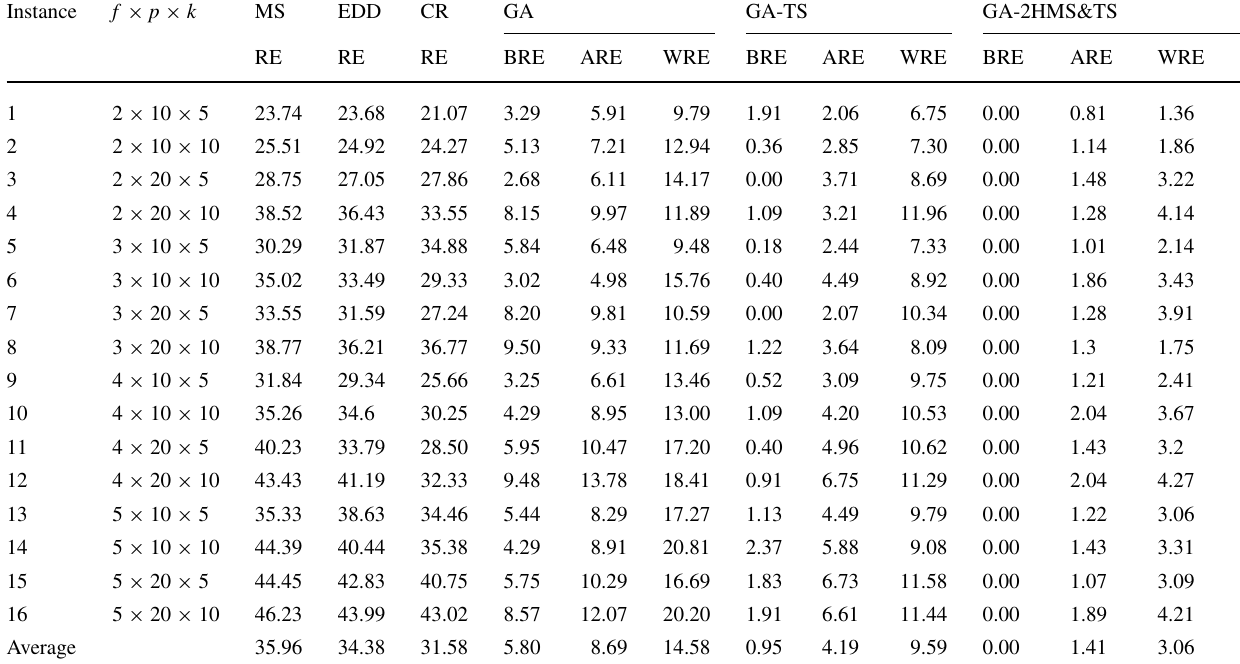
Table 7 RE value of different algorithms for small sized examples Instance